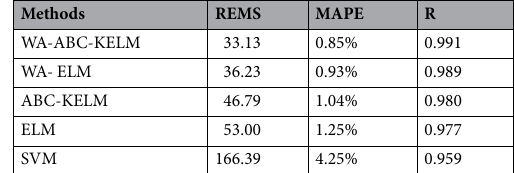
Table 3. The accuracy comparison of the prediction methods.